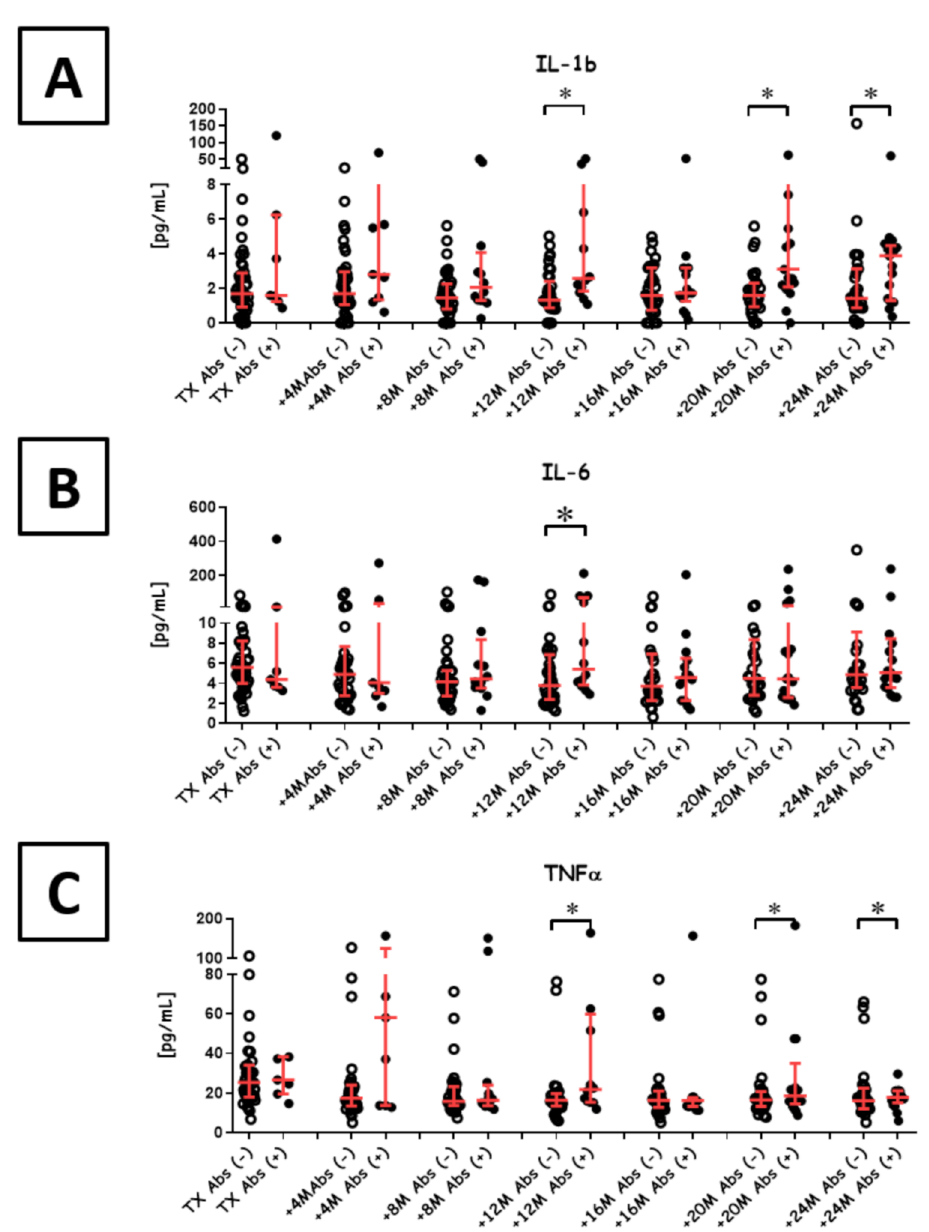
Figure 4. Pro-inflammatory cytokines during the first 2 y post-transplant. Serum IL-1b ( A ), IL-6 ( B ) and TNF α ( C ) levels in Abs − (open circles) and Abs+ (black circles) patients were compared across for each measured time point. * p < 0.05 based on Mann-Whitney U tests. The ratio of Abs − to Abs+ recipients at measured time points was as follows: transplant (45/7), +4 months (42/9), +8 months (40/12), +12 months (37/14), +16 months (35/15), +20 months (33/17) and +24 months